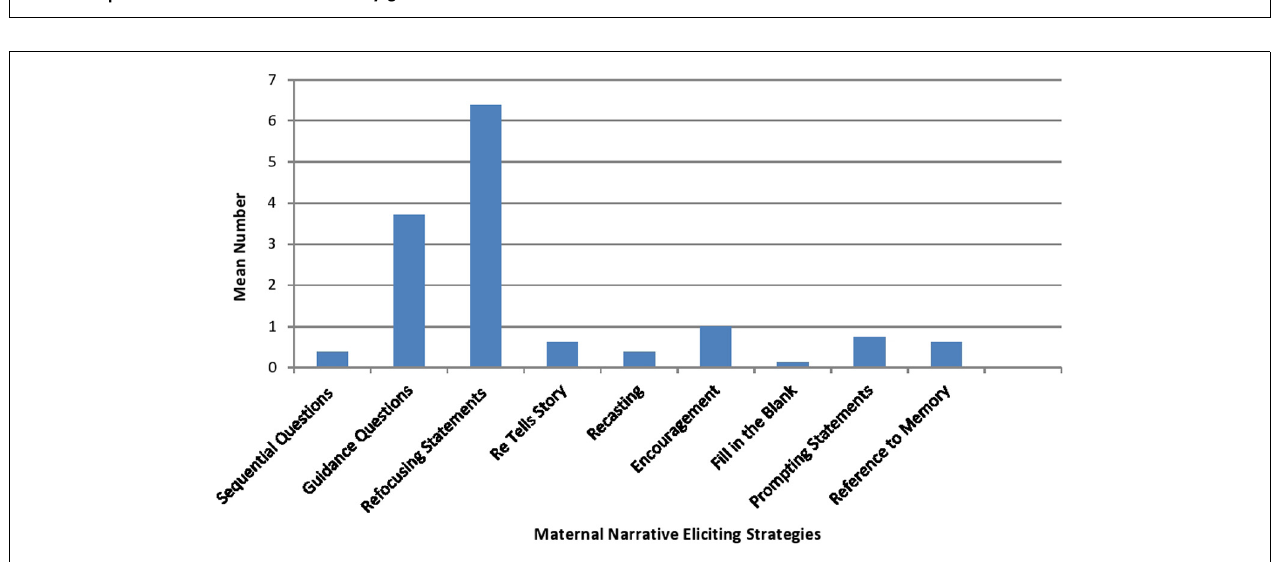
FIGURE 1 | Mean number of maternal story grammar elements.